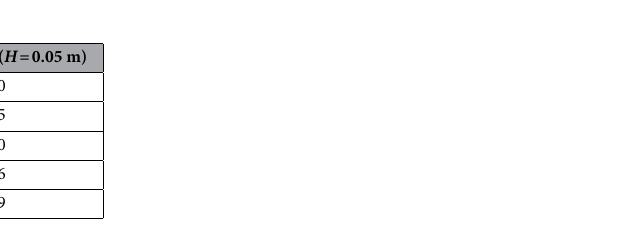
Table 1. Stable value of drag coefficient under different length-diameter